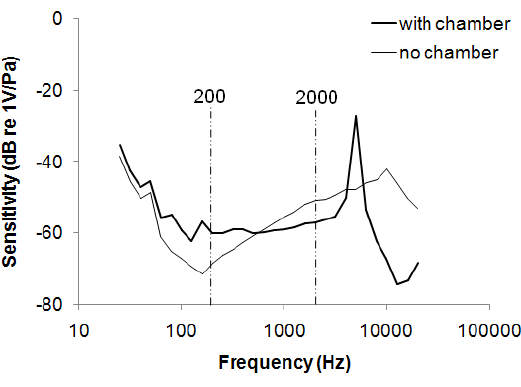
Figure 3. Frequency response of stethoscope with and without polyurethane/silica